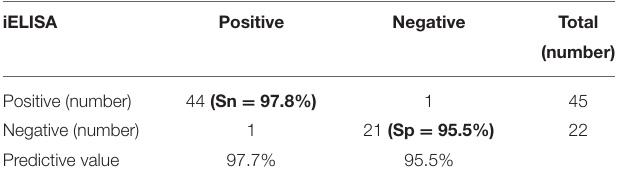
TABLE 4 | Diagnostic sensitivity (Sn) and specificity (Sp) of the iELISA based on mammalian cell-expressed N protein for detecting SARS-CoV-2-specific antibodies in cat serum